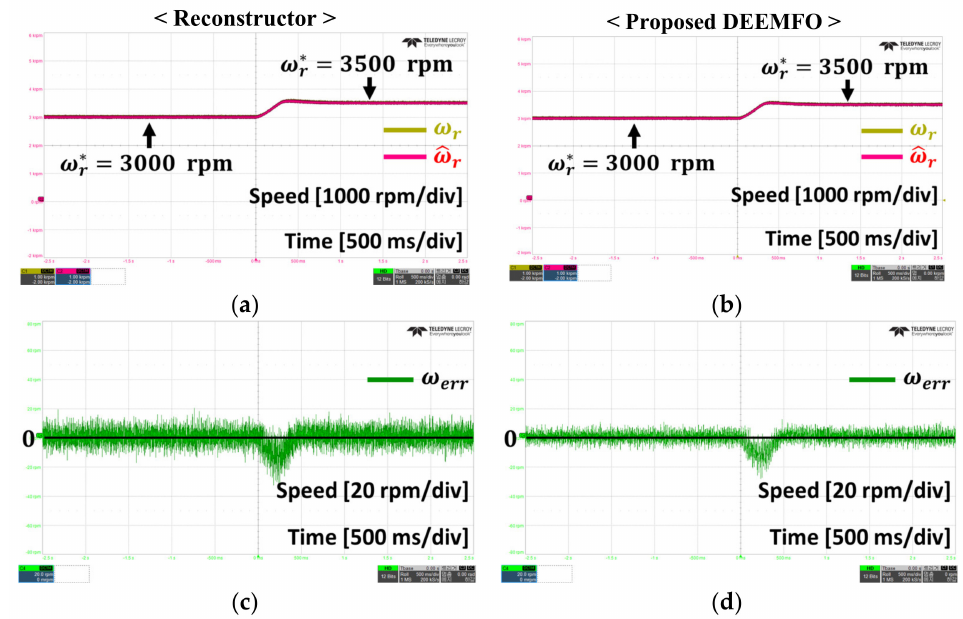
Figure 15. Summary of the experiment results on the condition of increasing the speed reference from 3000 rpm to 3500 rpm. ( a ) reference, real, and estimated speed with reconstructor; ( b ) reference, real, and estimated speed with DEEMFO; ( c ) speed error in reconstructor; ( d ) speed error in